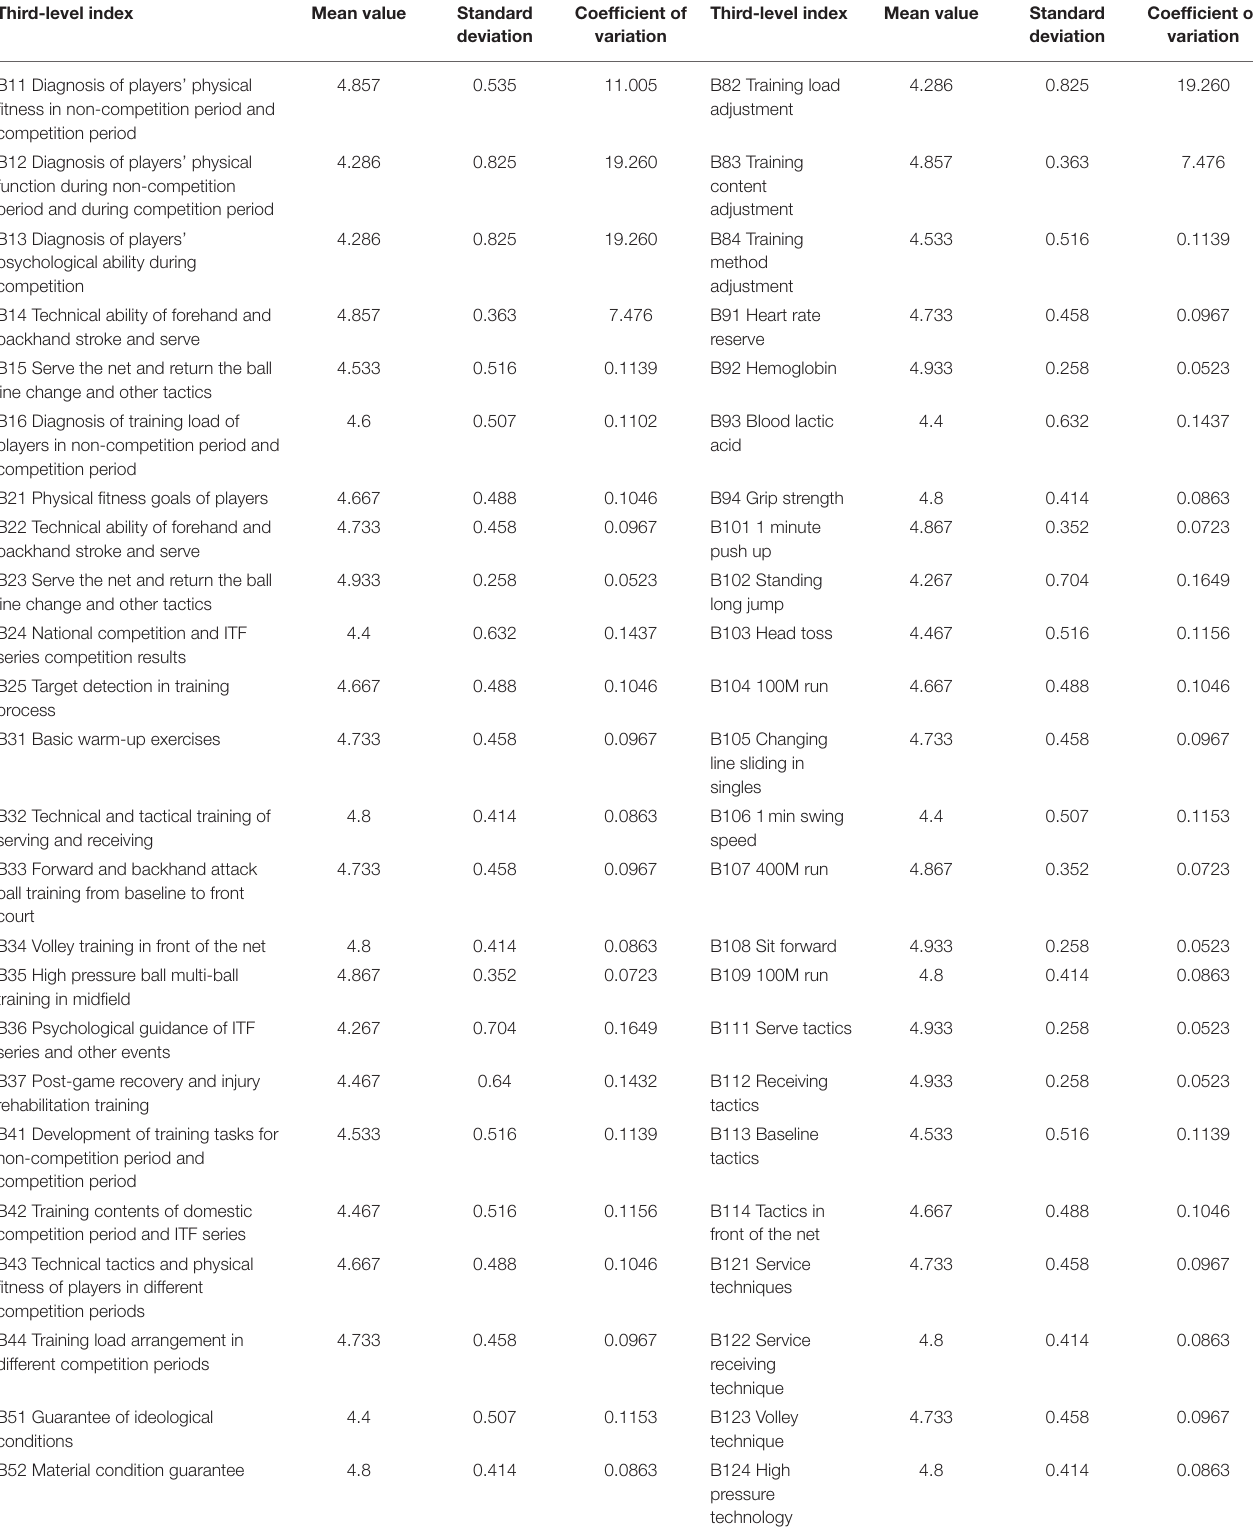
TABLE 12 | Indexes with “mean value” >